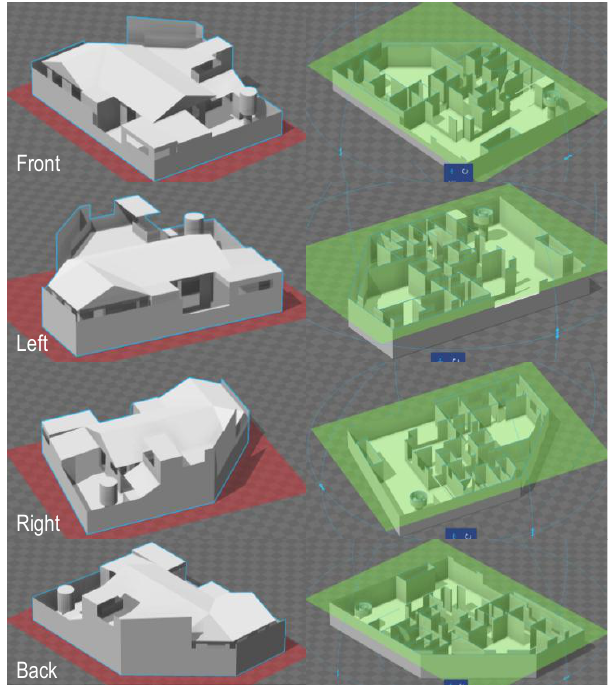
Figure 2. Detached family house and lot perimeter 3D external and internal views.